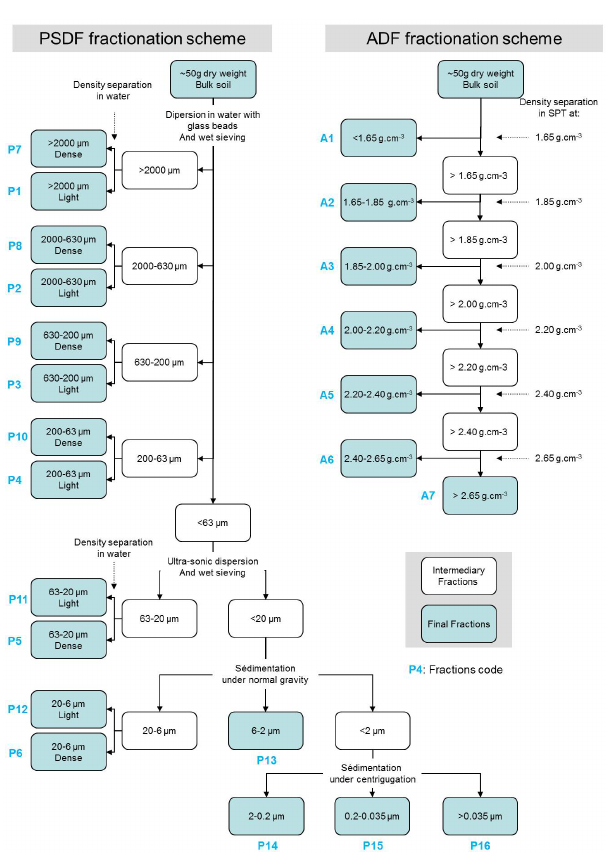
Fig. 2. PSDF and ADF fractionation